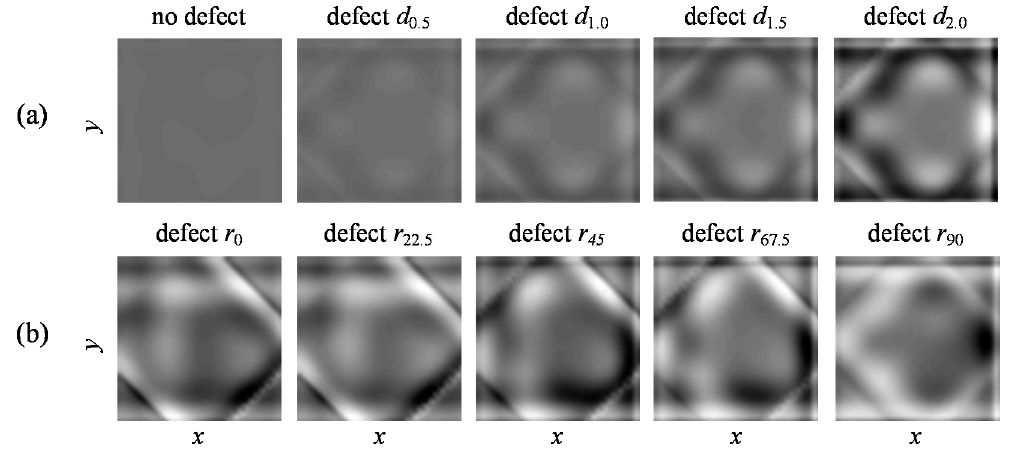
Figure 7. Selected results of reconstruction procedure obtained for: ( a ) different depth of the defects aligned at 0° ( r 0 ); ( b ) different orientation angle and depth of 2 mm ( d 2.0 ); the size of each reconstruction is 43 × 43.